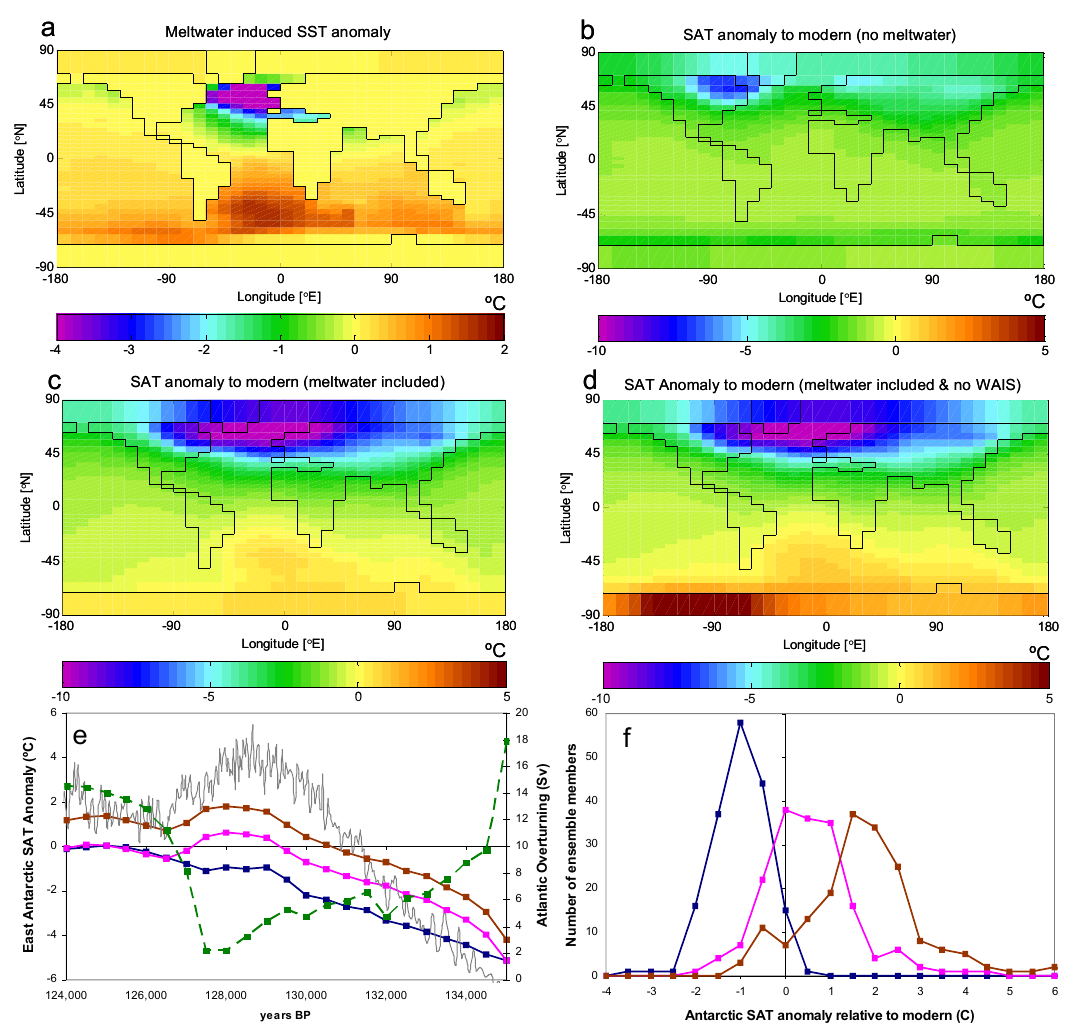
Fig. 4. GENIE-1 ensemble-averaged SST and SAT anomalies. Fields (at 128500 BP) of (a) meltwater induced SST anomaly (E FW - E NFW ) and (b, c, d) SAT anomalies relative to an equilibrium preindustrial ensemble E PI with (b) no meltwater flux (E NFW -E PI ) , (c) including Laurentide and Eurasian meltwater fluxes (E FW -E PI ) and (d) including Laurentide and Eurasian meltwater fluxes and replacing West Antarctic Ice Sheet with land at sea-level (E WAIS -E PI ) . (e) Ensemble-averaged temporal behaviour of East Antarctic SAT anomaly. The dashed green line is the ensemble-averaged (E FW ) Atlantic overturning (maximum streamfunction at depths below 400m). The grey line is the DOME C deuterium inferred anomaly (Jouzel et al., 2007). Solid lines are East Antarctic SAT anomalies with blue: no meltwater forcing (E NFW -E PI ) , pink: meltwater forcing included (E FW -E PI ) , brown: meltwater forcing included and WAIS removed to land at sea level (E WAIS -E PI ) . (f) Ensemble distributions of East Antarctic SAT anomaly at